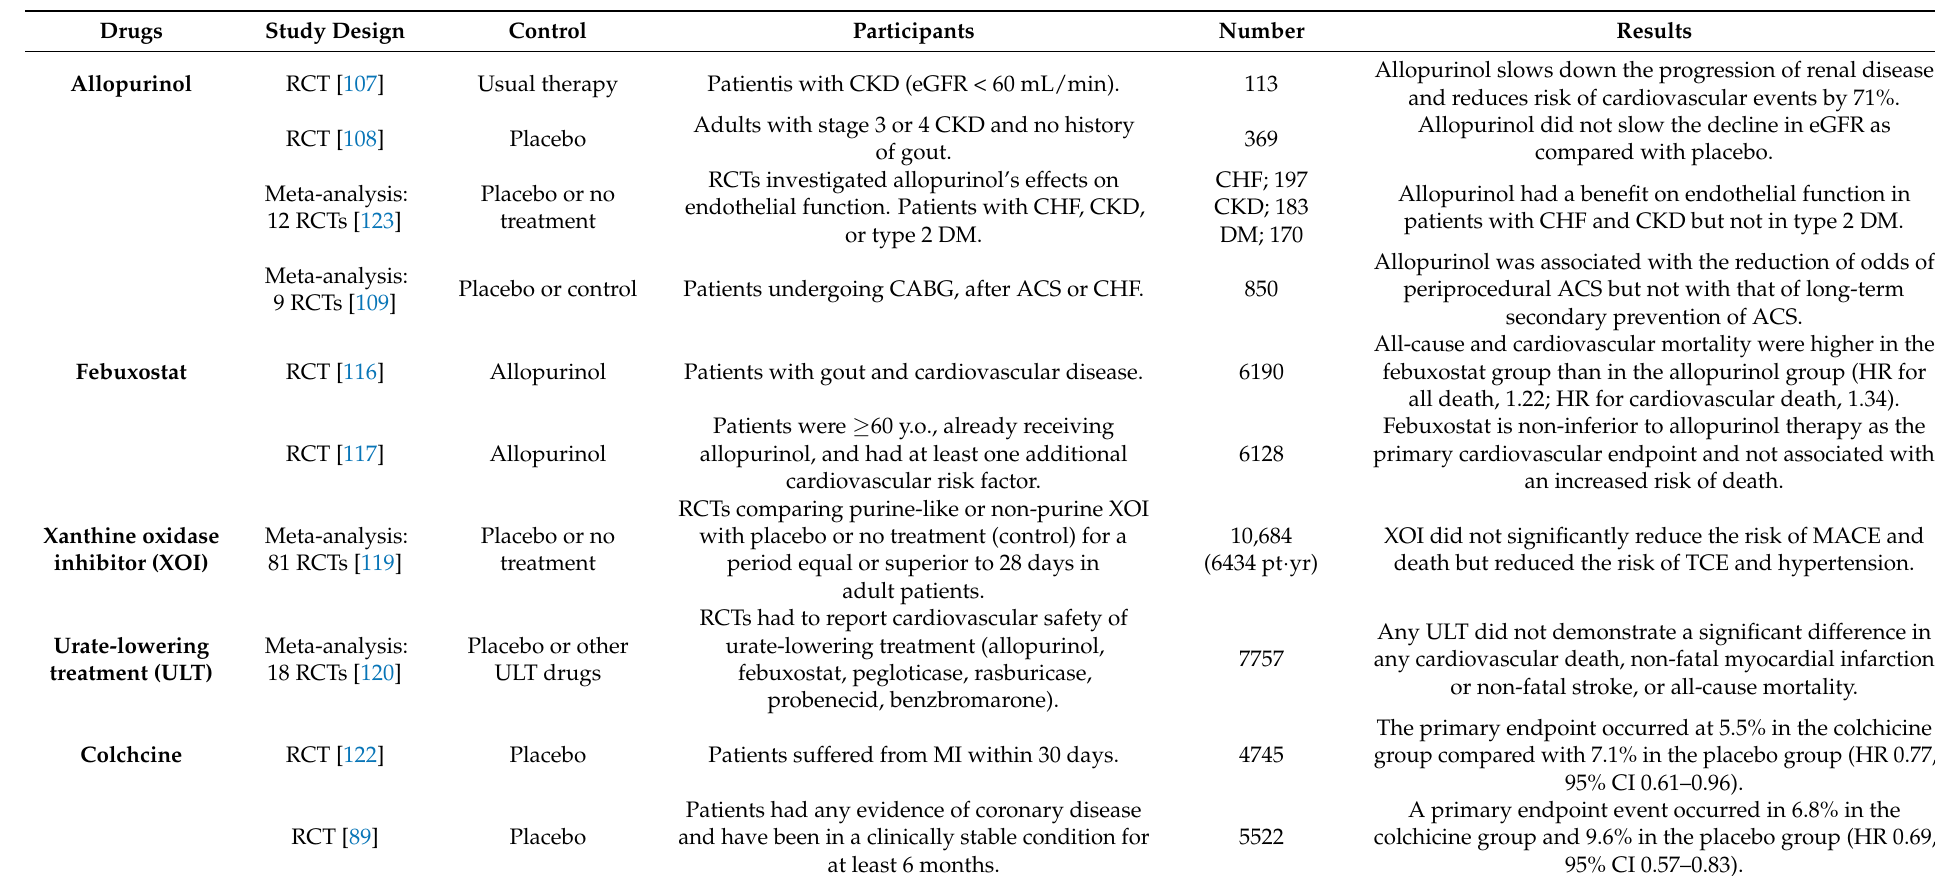
Table 1. Clinical trials for the efficacy of therapeutic agents of gout in cardiovascular